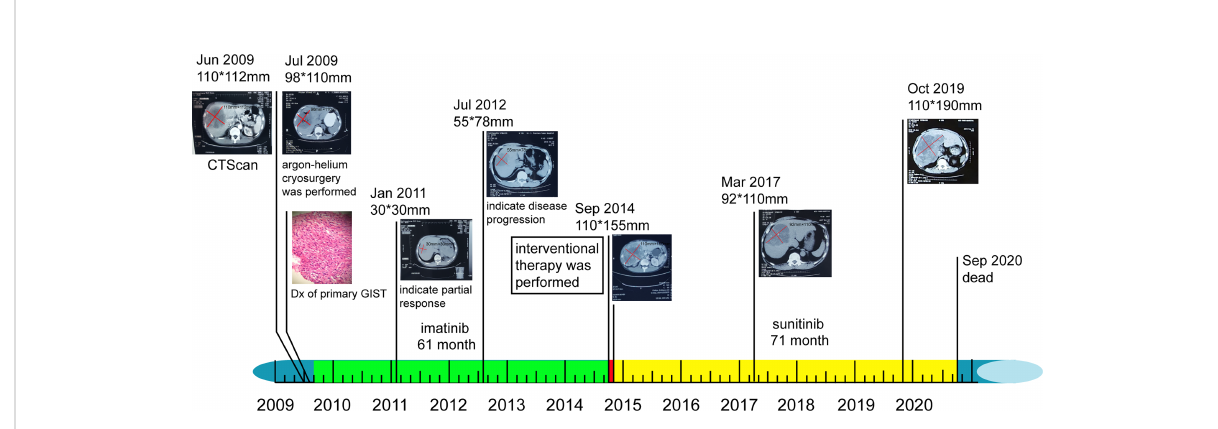
FIGURE 4 Timeline of patient ’ s diagnosis, treatment, and response. Colored rectangles near the timeline represent individuals ’ sequential therapy durations: green, imatinib therapy; red, interventional therapy; and yellow, sunitinib therapy. Original magni fi cation, ×400. Dx, diagnosis.